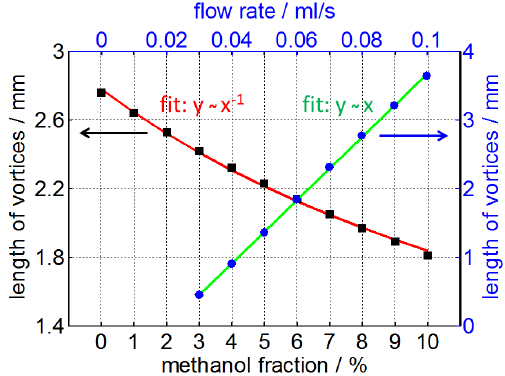
Figure 11. Simulated dependence of the stationary vortex pair length on flow rate of water and methanol fraction at a flow rate of 0.08mLs − 1